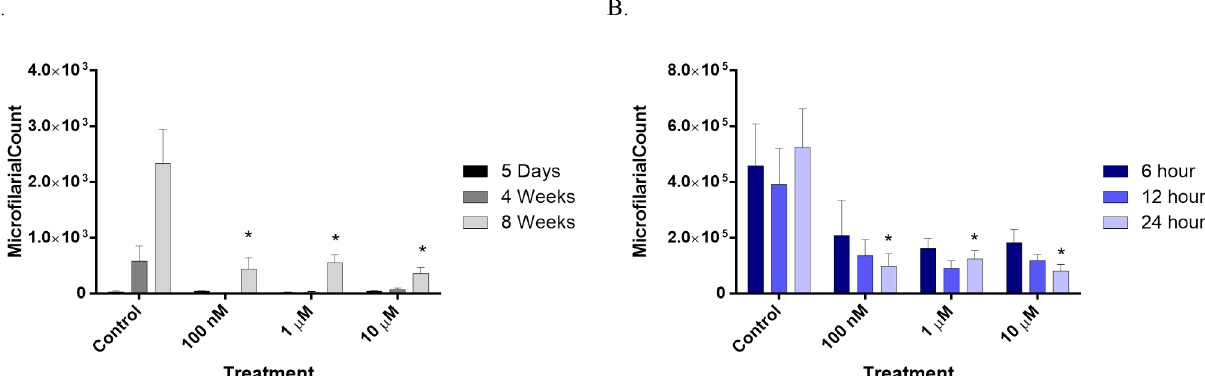
Fig 2. Effects of FLBZ on recovery of microfilariae from the peritoneal cavity of jirds. A. Five day, four week, or eight week maintenance after transplantation into na ï ve jirds following 24 hr culture. Data is a combination of two experiments. Microfilariae were enumerated from the peritoneal wash of each of three jirds which had 10 female worm transplanted in experiment one (5 day and 4 week maintenance) and 15 females in experiment two (4 and 8 week maintenance). Data were corrected for number of females transplanted. The 4 week data from each experiment did not differ significantly, therefore, they were combined for presentation purposes. B. Recovery eight weeks post-transplantation following 6, 12, or 24 hr exposure to FLBZ in vitro . Microfilariae were enumerated from peritoneal washes of each of three jirds which had 15 females worms transplanted, following the appropriate duration of in vitro exposure to FLBZ. Bars indicate the mean mf counts from each jird in a treatment group. Lines represent the standard deviation.